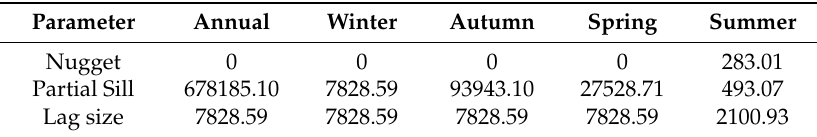
Figure 3. Spherical semivariograms of ordinary kriging interpolation models for annual and seasonal rainfalls. Table 9. Variogram Statistics.